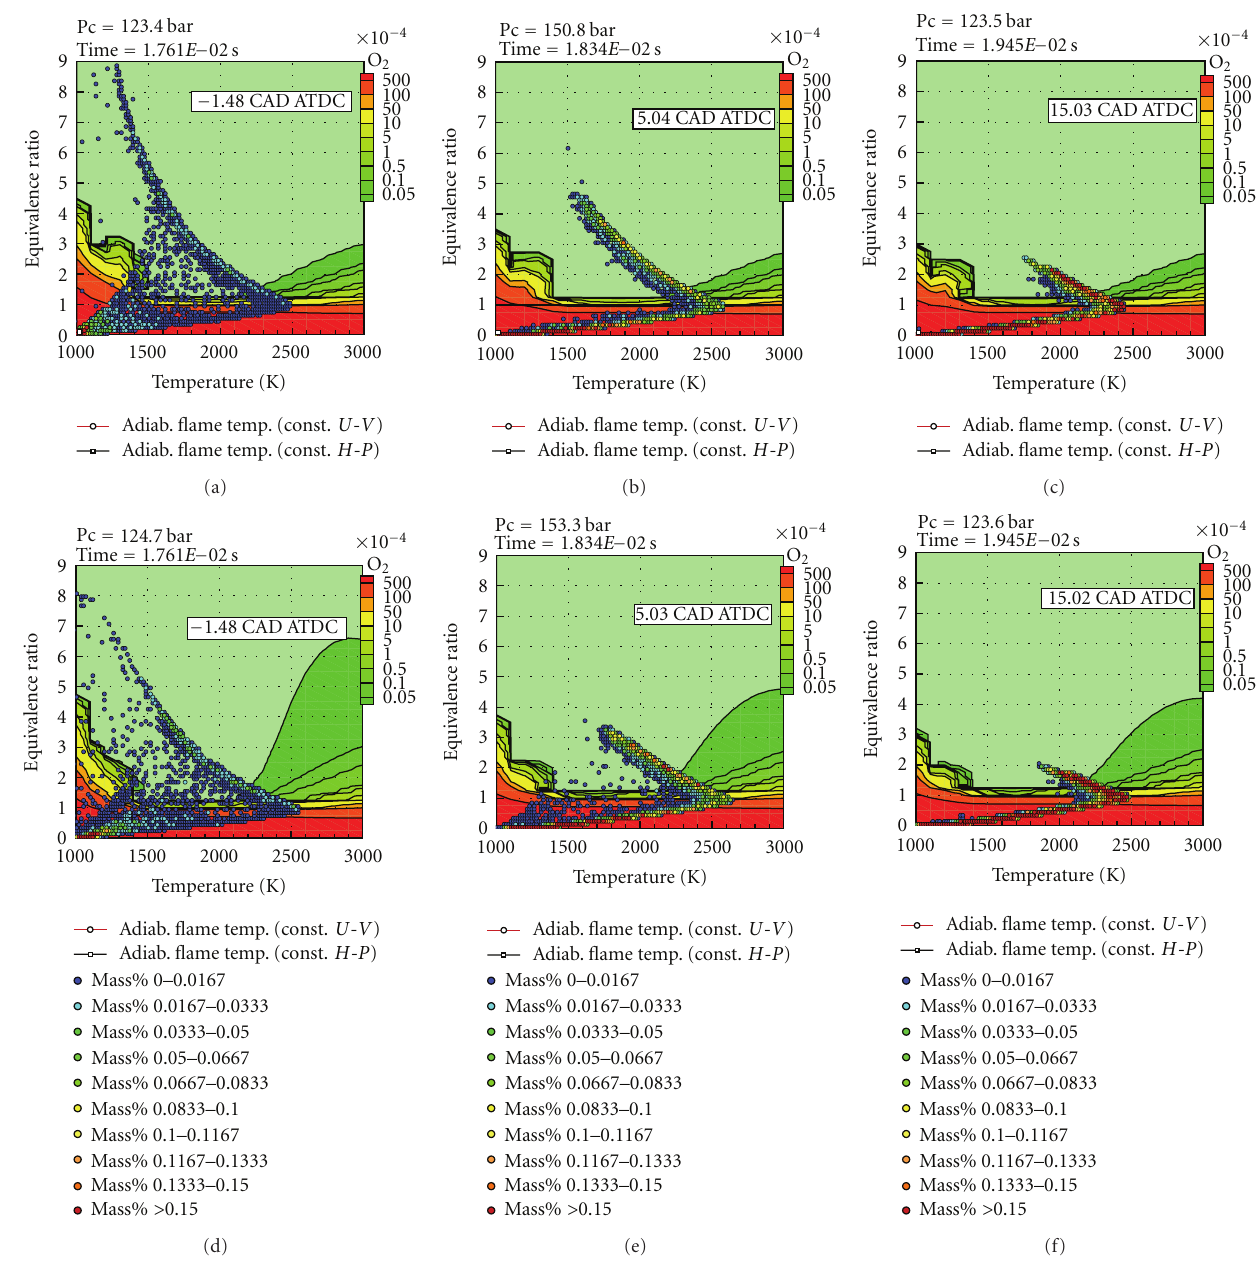
Figure 16: Parametric φ - T maps for instant O 2 concentrations in the Volvo D12C Diesel engine fuelled by DOS (a, b, and c) and RME (d, e, and f) at di ff erent CADs ( − 1.5, 5.0, and 15.0, resp.); the engine was operated under 50% load with 30% EGR.